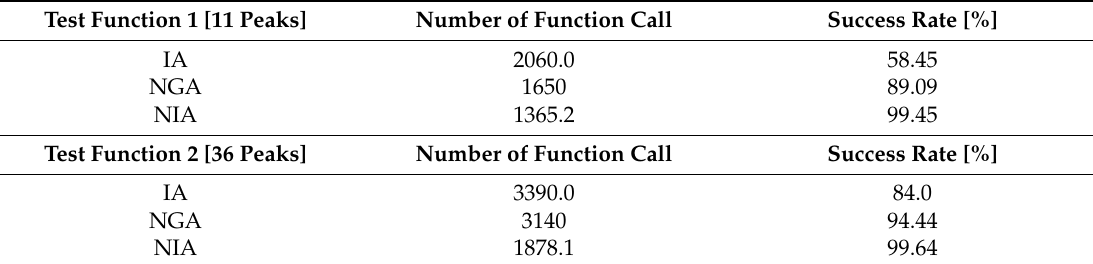
Figure 6. Three-dimensional plot of test functions: ( a ) Test function 1 with 11 peaks; ( b ) Test function 2 with 36 peaks. Table 2. Performance comparison between the NIA, IA, and NGA.